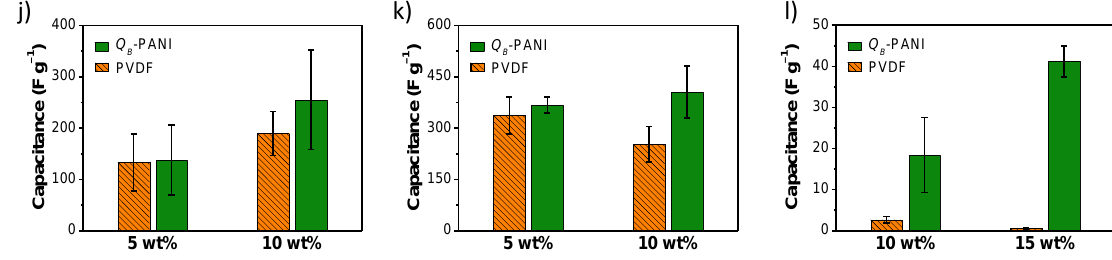
Figure 17. Electrode binder performance of an intrinsically conductive PANI glue: SEM images of nanoparticle electrodes prepared with a 10 wt.% PANI binder content: ( a ) PPy nanospheres, ( b ) PANI nanofibrils, and ( c ) carbon black. Representative CV curves and galvanostatic charge–discharge curves of the electrodes recorded at a scan rate of 25 mV·s −1 and a current density of 0.1 A·g −1 , respectively, in 1 M sulfuric acid: ( d and g ) PPy nanospheres, ( e and h ) PANI nanofibrils (5 wt.% and 10 wt.% binder contents), and ( f and i ) carbon black electrodes with 10 wt.% and 15 wt.% binder. Gravimetric